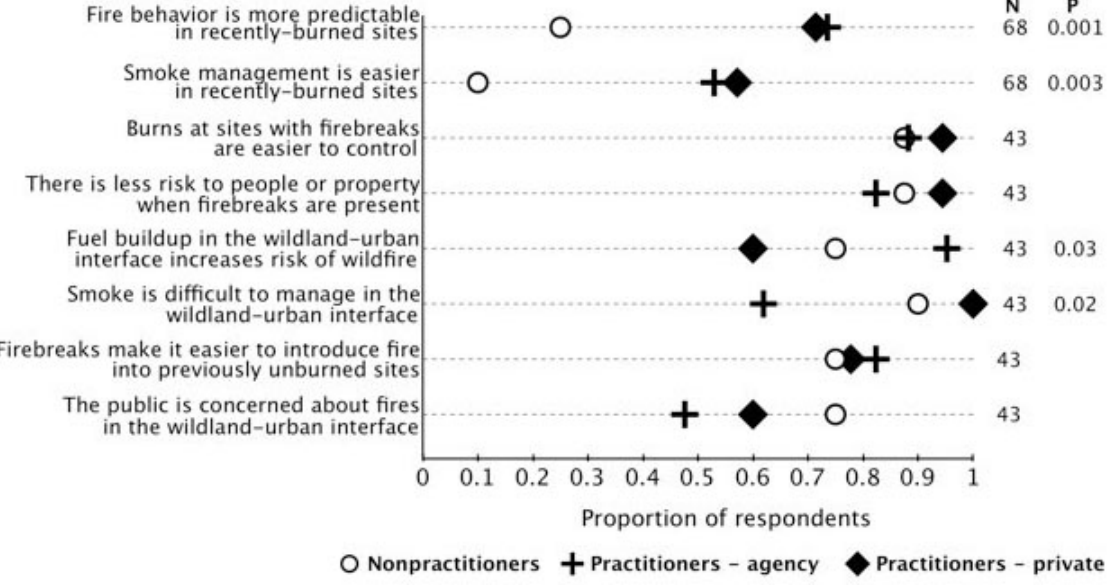
Fig. 5. Proportion of survey respondents who agreed with each rationale related to impacts to people or property. P-values are listed for rationales for which there is a significant difference among stakeholder